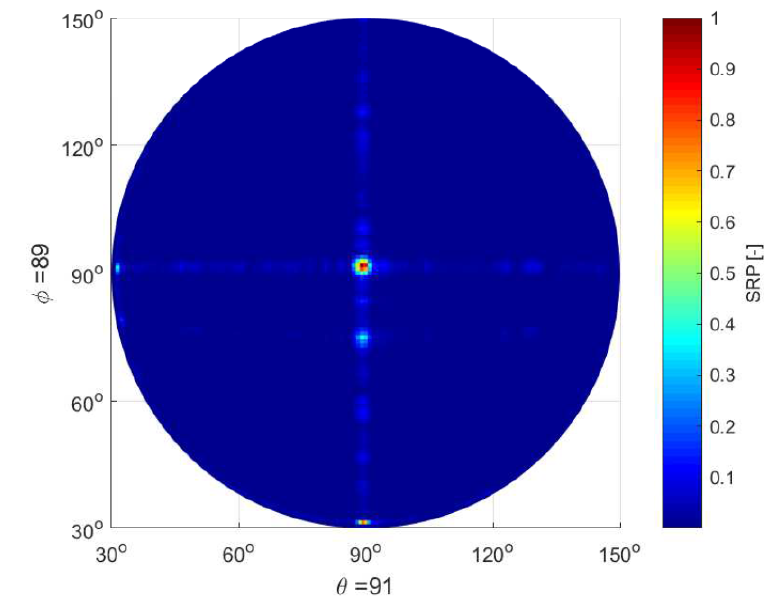
Figure 21. Result of testing the system for capturing sounds from a height of 100 m.